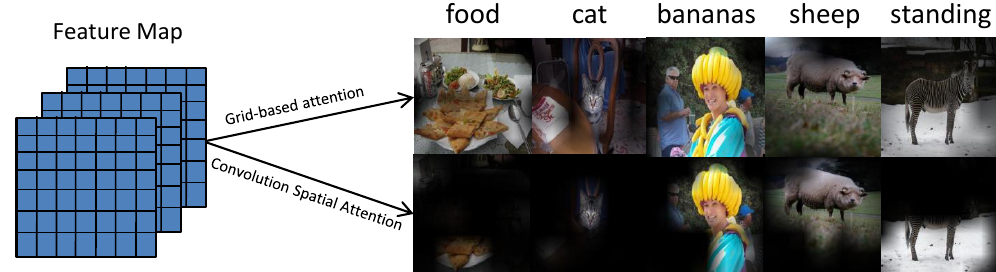
Figure 1. The illustration of the generated attention maps when predicting certain words for our convolutional spatial attention mechanism, comparing with the traditional grid-based attention